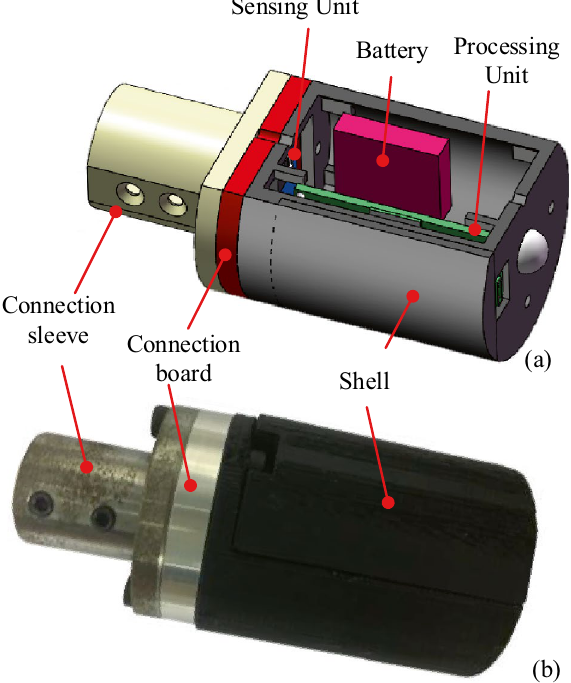
Figure 3. Three-dimensional illustration of the structural model: ( a ) assembly structure and ( b ) physical appearance.